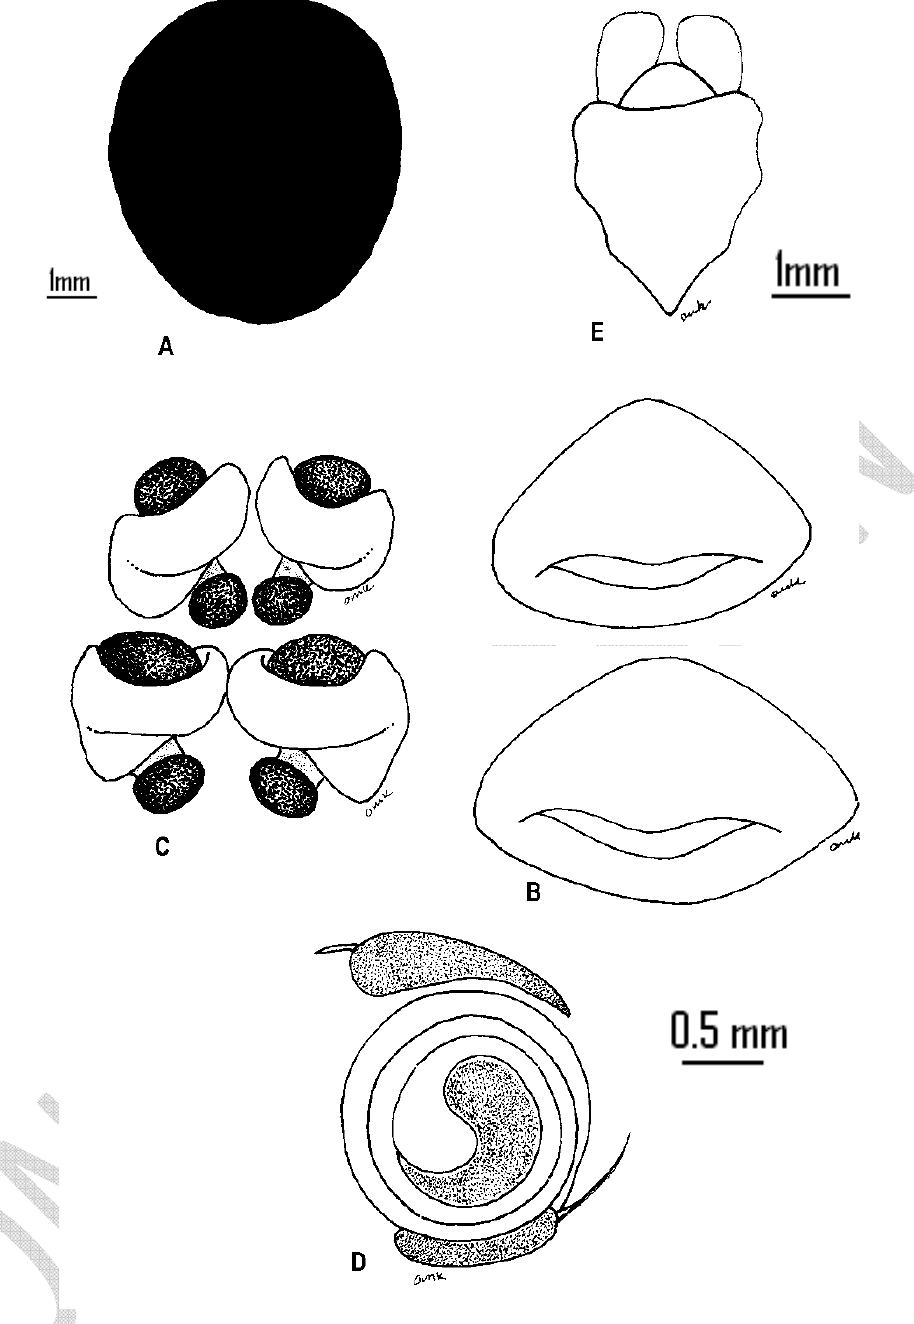
_ F IG .4 . Latrodectus dahlia . A) Abdomen, dorsal pattern female; B) Epigynum; C) Genitalia; D) Male left palpus ; E) Sternum Epigynum: Typical, wider than long and with a transverse groove on each side of openning. Spermathecal ducts with two loops. The embolus is shorter than two other species and with two loops (Fig4B, C). Male palpus: The embolus with three loops as in L.tredecimguttatus (Fig.4D). Habitat: Web is on ground as in L.tredecimguttatus . Egg sacs are fluffy, white and globular. Records: Gonabad (Kakhk, Zibad), Birjand. Previously, this species was recorded from southern part of Iran (Bushire); Israel and Central